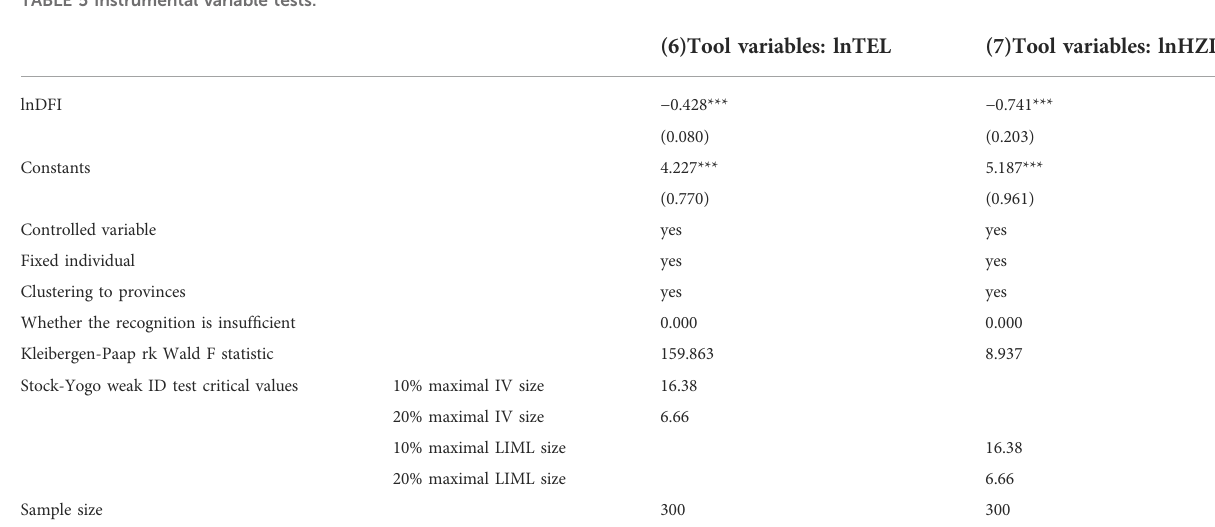
TABLE 5 Instrumental variable